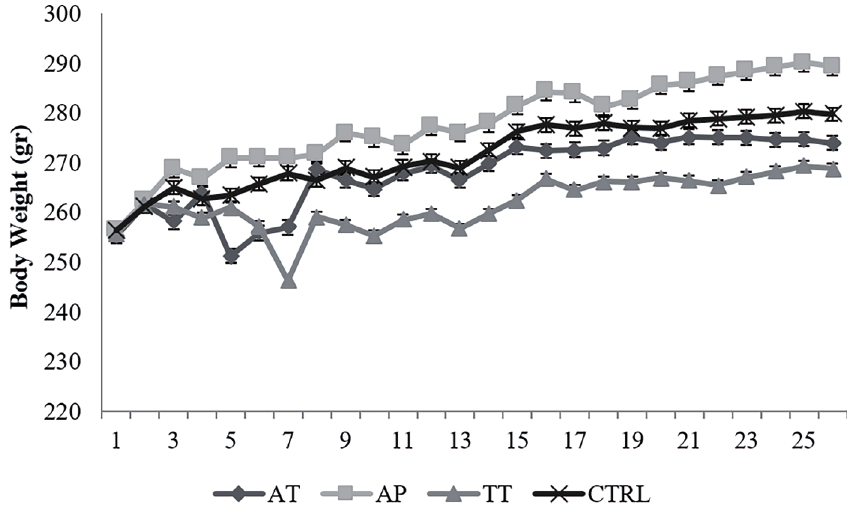
Figure 1- The body weight of animals was recorded